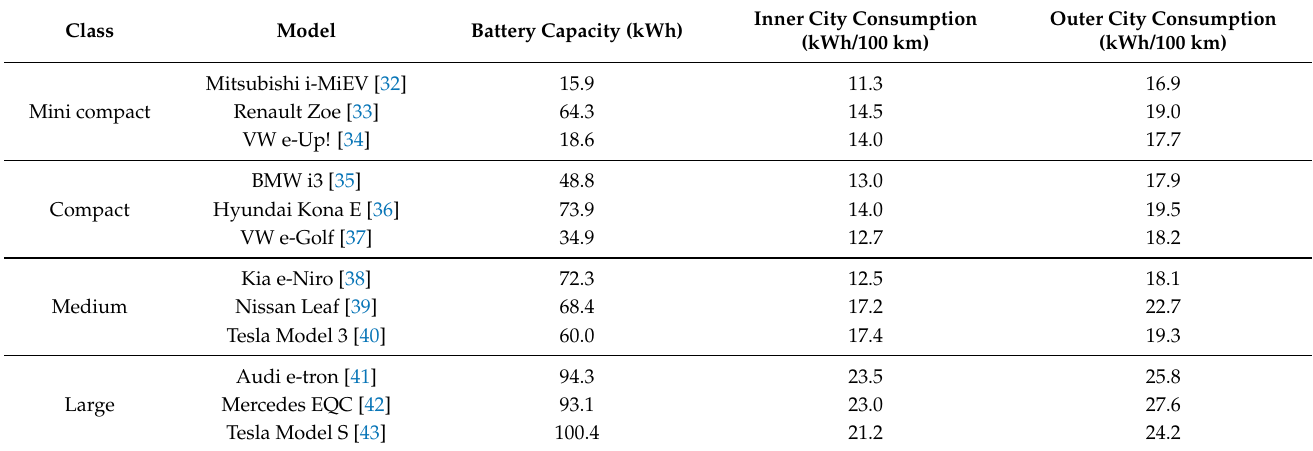
Table 2. Reference